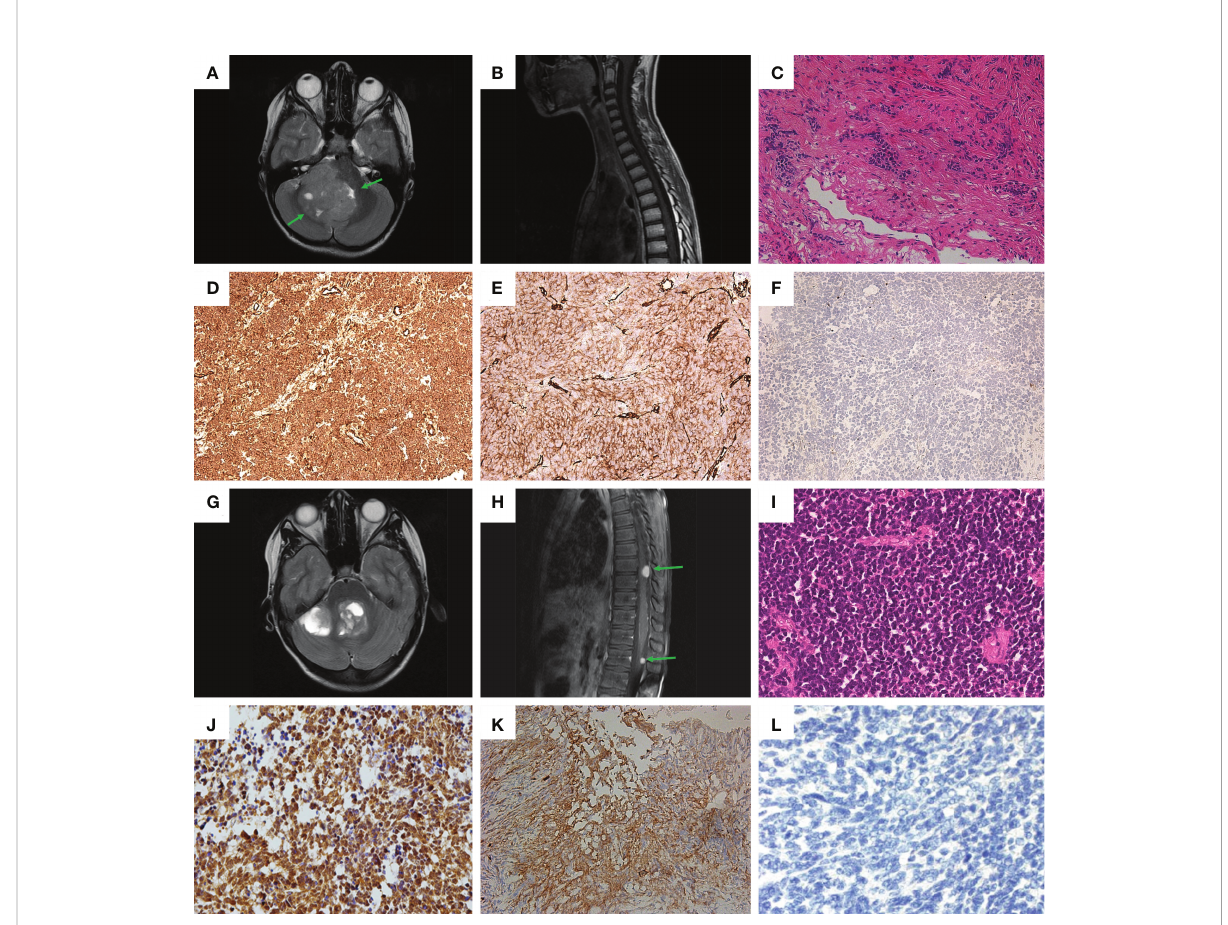
FIGURE 1 Clinical and histological characteristics. (A, B) – MRI screens in Patient #1 : (A) brain; (B) spinal cord; (C) Hematoxylin-eosin staining of sample from Patient #1 . (D-F) Immunohistochemical (IHC) staining of tumor sample from Patient #1 : (D) beta-catenin; (E) fi lamin A; (F) GAB1. (G, H) MRI screens in Patient #2 : (G) brain; (H) spinal cord. (I) Hematoxylin-eosin staining of sample from Patient #2 . (J – L) IHC staining of tumor sample from Patient #2 : (J) beta-catenin; (K) fi lamin A; (L)